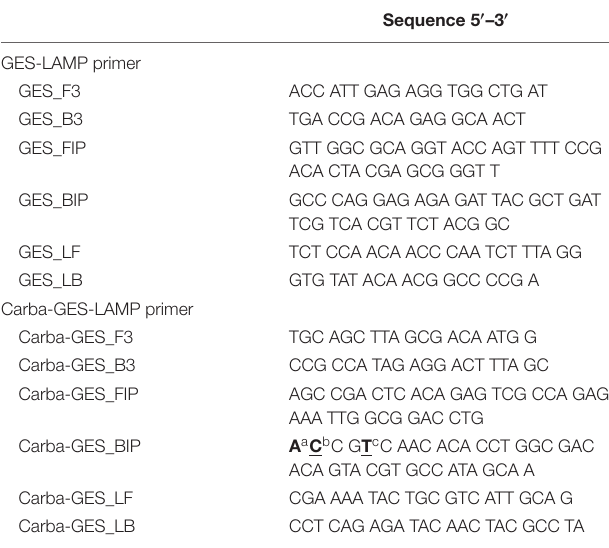
TABLE 3 | LAMP primer sets used for genotypic identification of bla GES and the single missense mutation (G493A) that changes glycine 165 to a serine, endowing the enzyme with carbapenemase